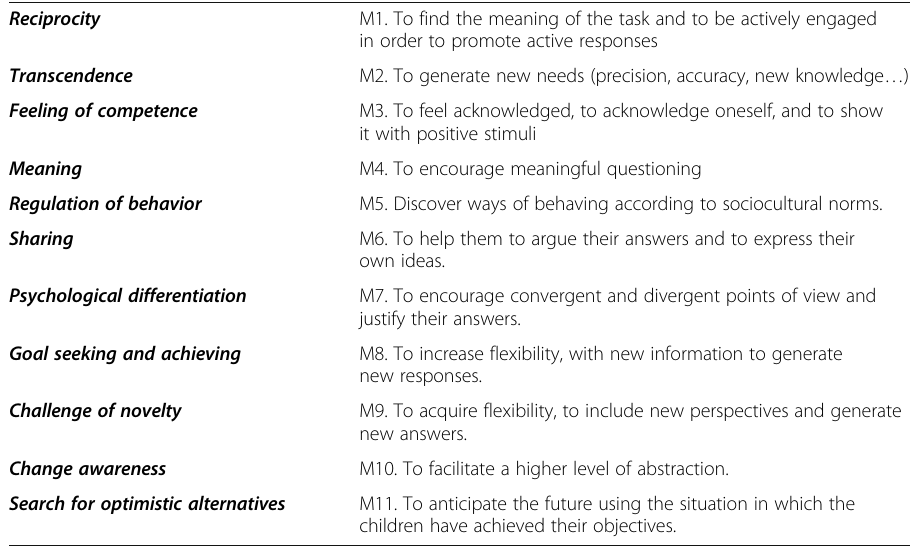
Table 1 Feuerstein ’ s mediation categories Reciprocity M1. To find the meaning of the task and to be actively engaged